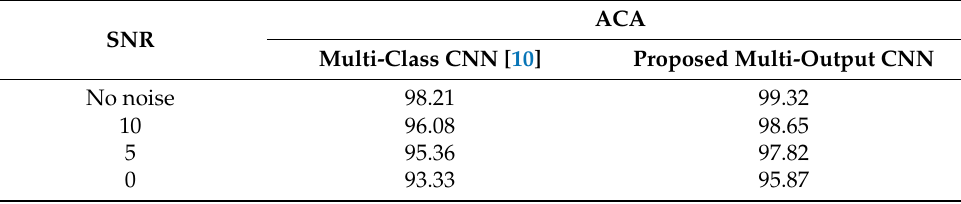
Table 5. Comparison of average accuracy between two CNN-based methods under noisy